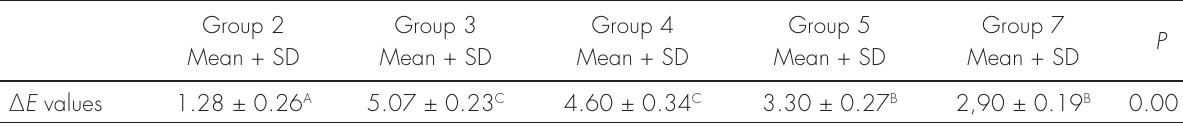
Table V. Color change results for 72 hr